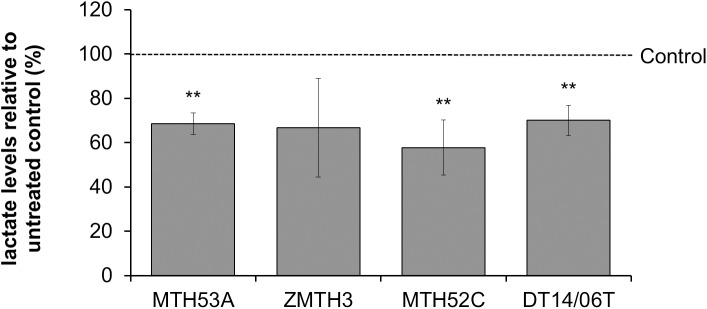
Effect of 10 mM DCA on lactate release of mammary cell lines after 48 hours.In comparison to untreated control significant reduction of lactate production was proved in all cell lines except the benign mammary adenoma (ZMTH3). No significant difference was evaluated between MTH53A and the other cell lines. Data are shown as mean ± SD, n≥3 and are presented as relative lactate content in comparison to untreated control (%). Control was set to 100%. Statistical analysis was performed with two-tailed t-test, *p<0.05, **p<0.01, ***p<0.001.